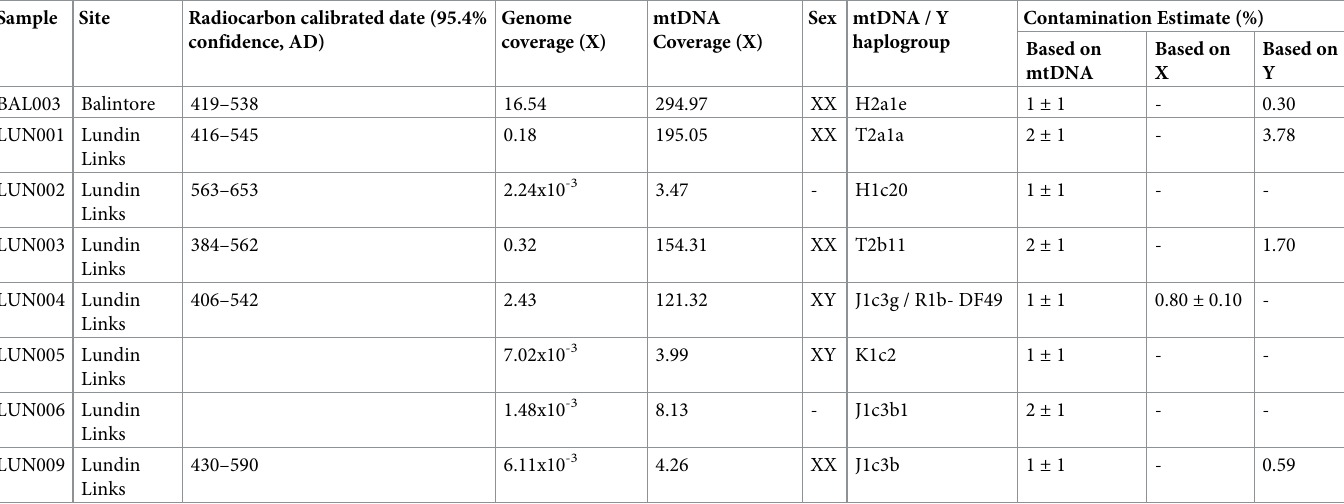
Table 1. Summary information from the eight samples investigated in this study. Sample